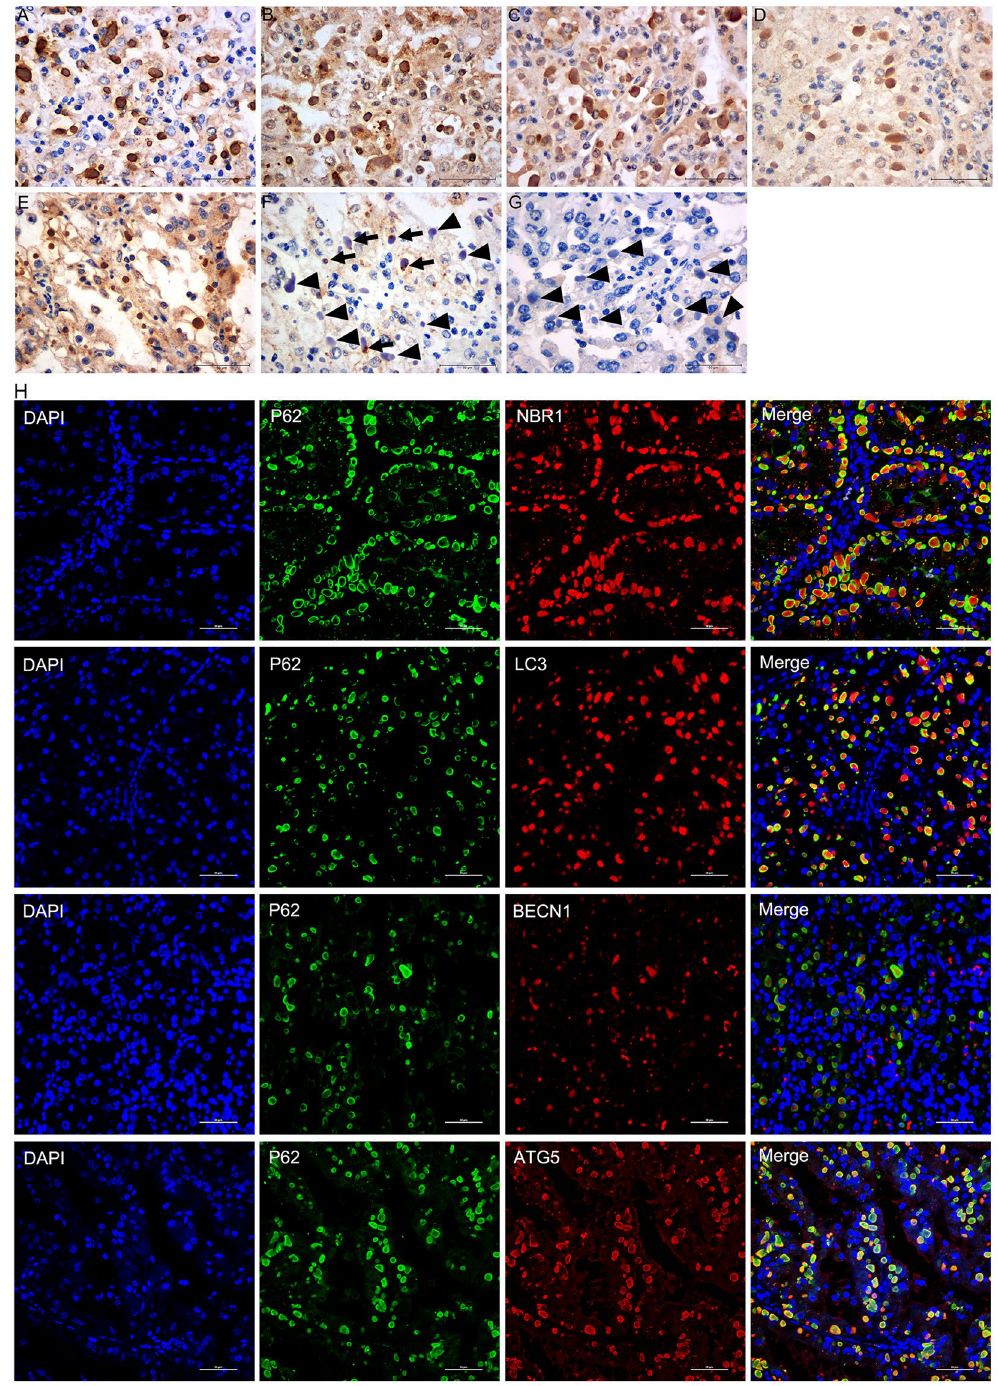
Figure 3. Immunohistochemical staining and double-immunofluorescence labeled microscopic images of ECIs in RCCs. Immunohistochemical staining showed that the ECIs were immunopositive for P62 ( A ), NBR1 ( B ), LC3 ( C ), BECN1 ( D ), and ATG5 ( E ), and immunonegative for LCK (arrows in G ). Ub1 immunopositivity was detected in a small number of ECIs (arrows in F ). Double-immunofluorescence staining of ECIs demonstrated co-localization of P62 with NBR1, LC3, BECN1 or ATG5 in ECIs ( H